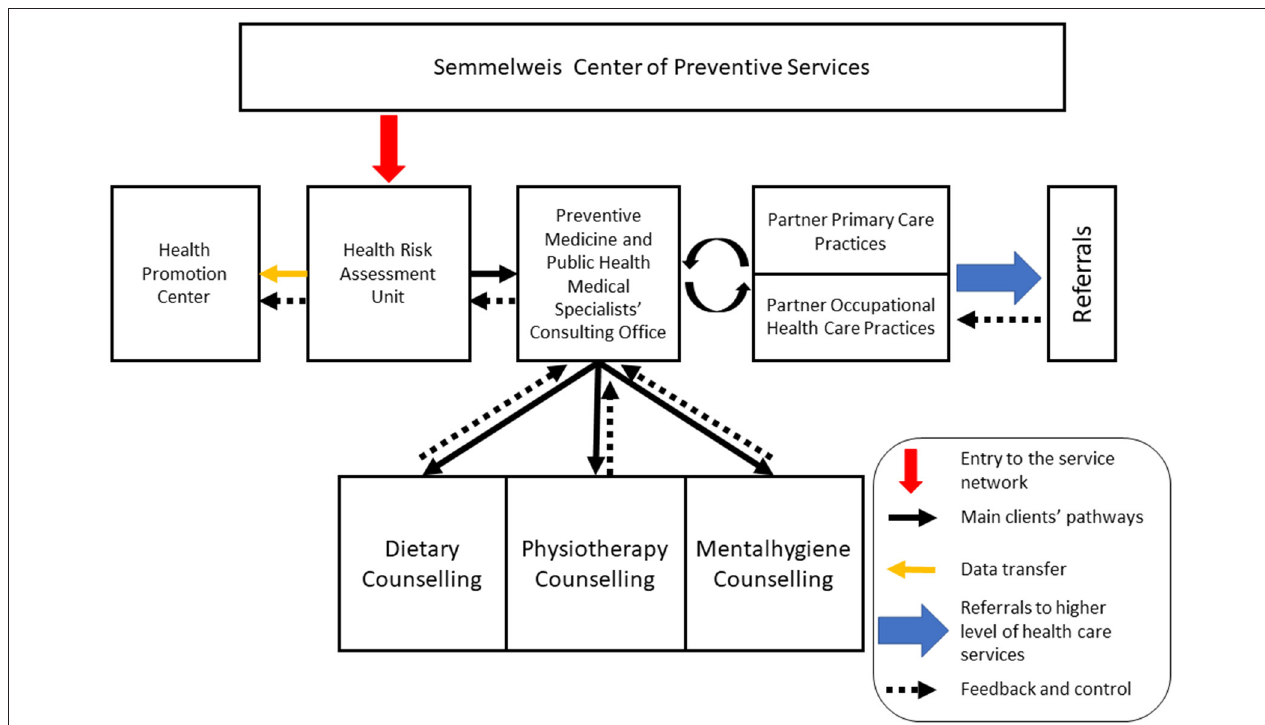
FIGURE 1 | Structure of the Semmelweis Center of Preventive